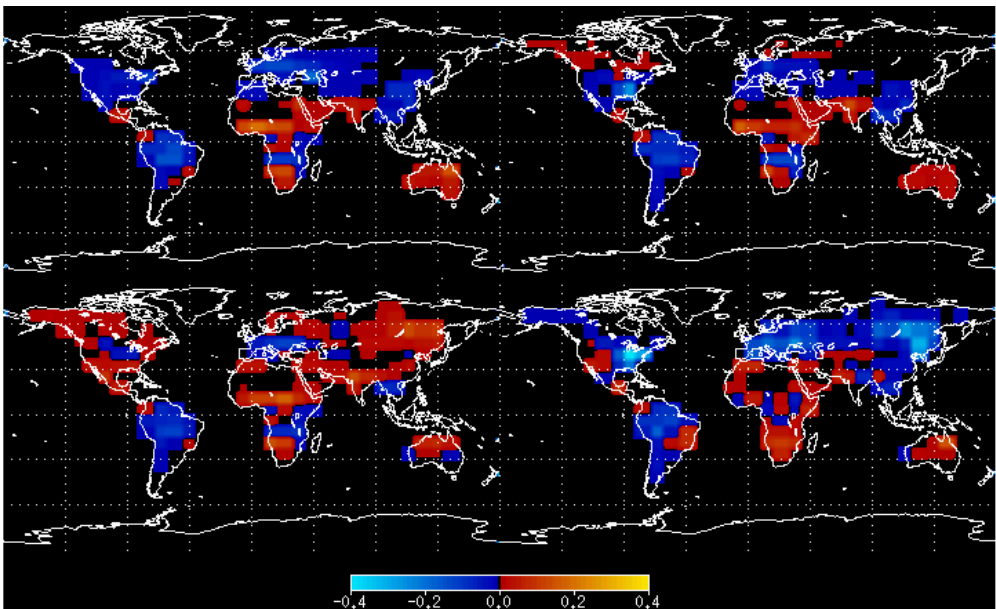
Fig. 3. Posterior-prior FAPAR for 4 months in 2003: January (upper left panel), April (upper right panel), July (lower left panel), and October (lower right